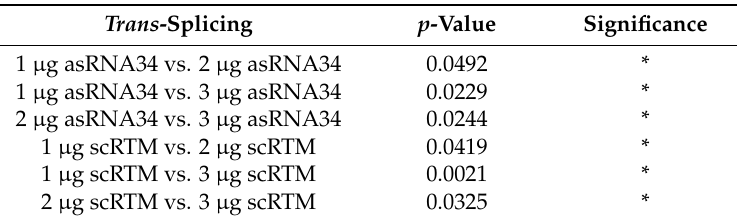
Figure 5. The impact of asRNA34 on cis -splicing in the fluorescence-based setting. The transfection experiments further revealed an asRNA34 dose-dependent increase of the trans -splicing efficiency confirmed via flow cytometric analysis at protein level ( A ) and via sqRT-PCR at mRNA level ( B ). The asRNA34-mediated trans -splicing increment was accompanied by increased cis -splicing levels, detected via sqRT-PCR and normalized to GAPDH mRNA levels ( C ) (the mean value + SD of one representative experiment is shown), indicating a stabilizing effect on the target pre-mRNA by antisense molecule interference. Empty pcDNA 4.0 expression plasmids were transfected into HEK293 cells to adjust total plasmid levels delivered into the target cells. Increasing the amount of transfected RTMs results in an increased GFP expression as detected via flow cytometry ( D ) and sqRT-PCR ( E ) , although the cis -splicing rate within the KRT14 -scMG remains largely unaffected ( F ). An unpaired Student’s t -test (two-tailed) was performed with the GraphPad Prism software (GraphPad Software, San Diego, CA, USA) to prove statistical significance (Tables 2 and 3). Significance values are given in asterisks (ns = not significant; * p -value ≤ 0.05; ** p -value ≤ 0.01). Table 2. Statistical significance trans -splicing Figure